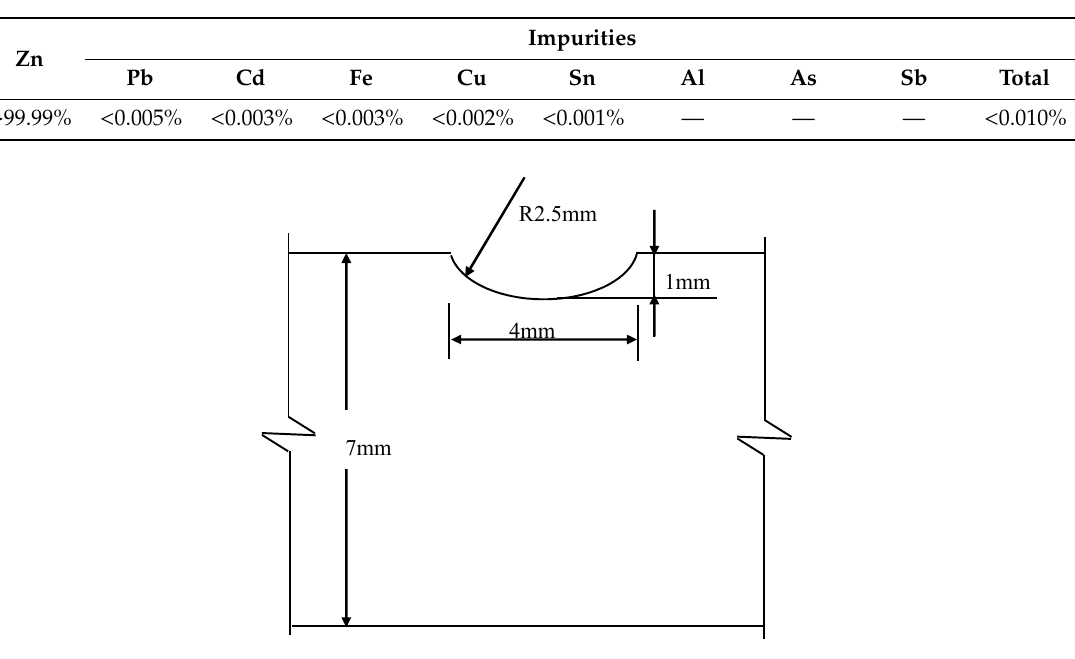
Figure 1. Schematic diagram of machine-cut notch.